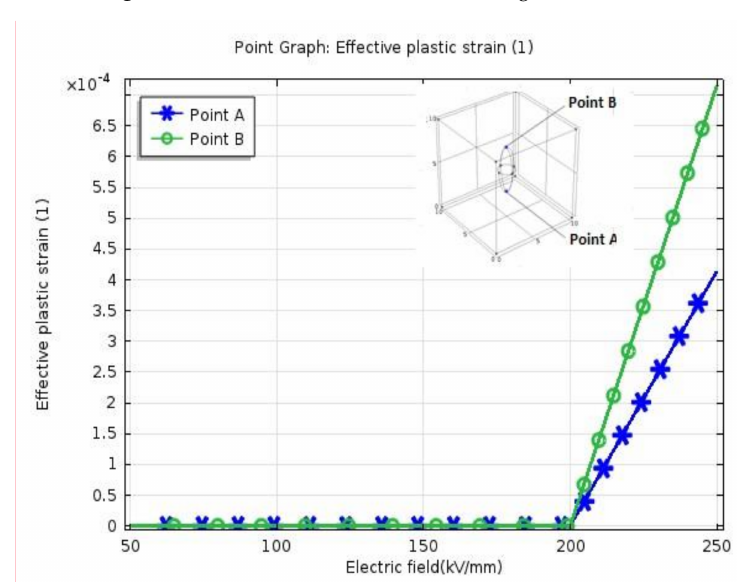
Figure 14. E ff ective plastic strain with increasing electric